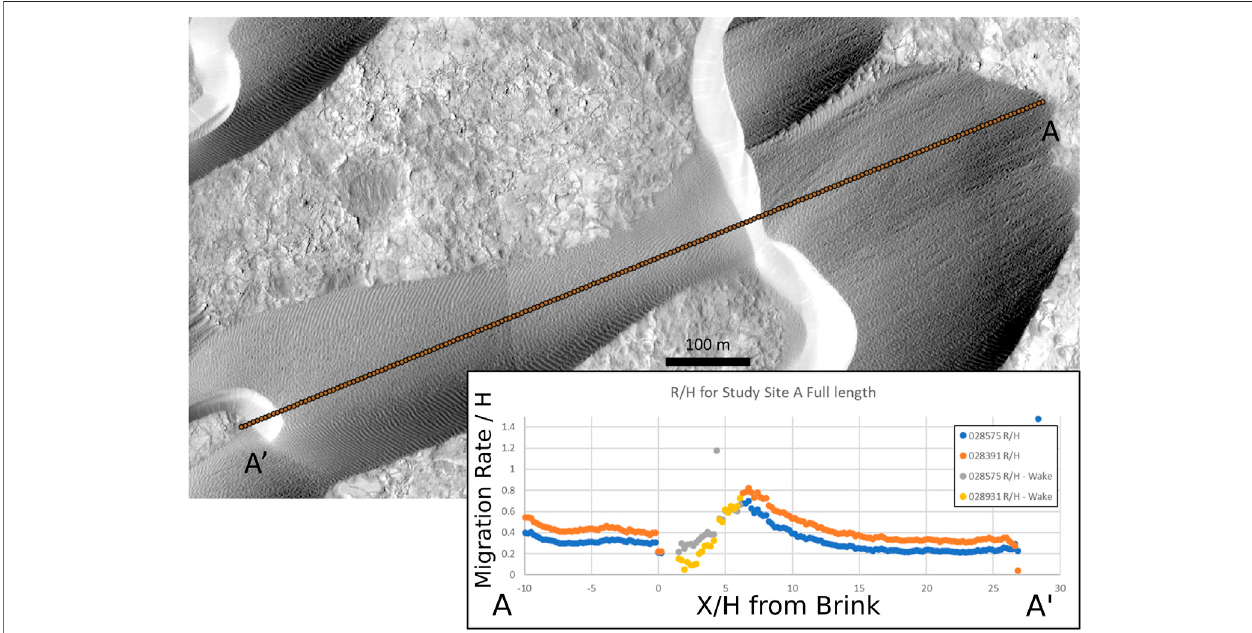
FIGURE8| FulltransectforSiteA.ThistransectwaschosentoexploretheR/Halongthefulllengthoftheseconddune,whichwasnotexploredintheoriginaldata. This transect runs parallel to the morphology of the dune, rather than the wind direction implied from COSI-Corr.